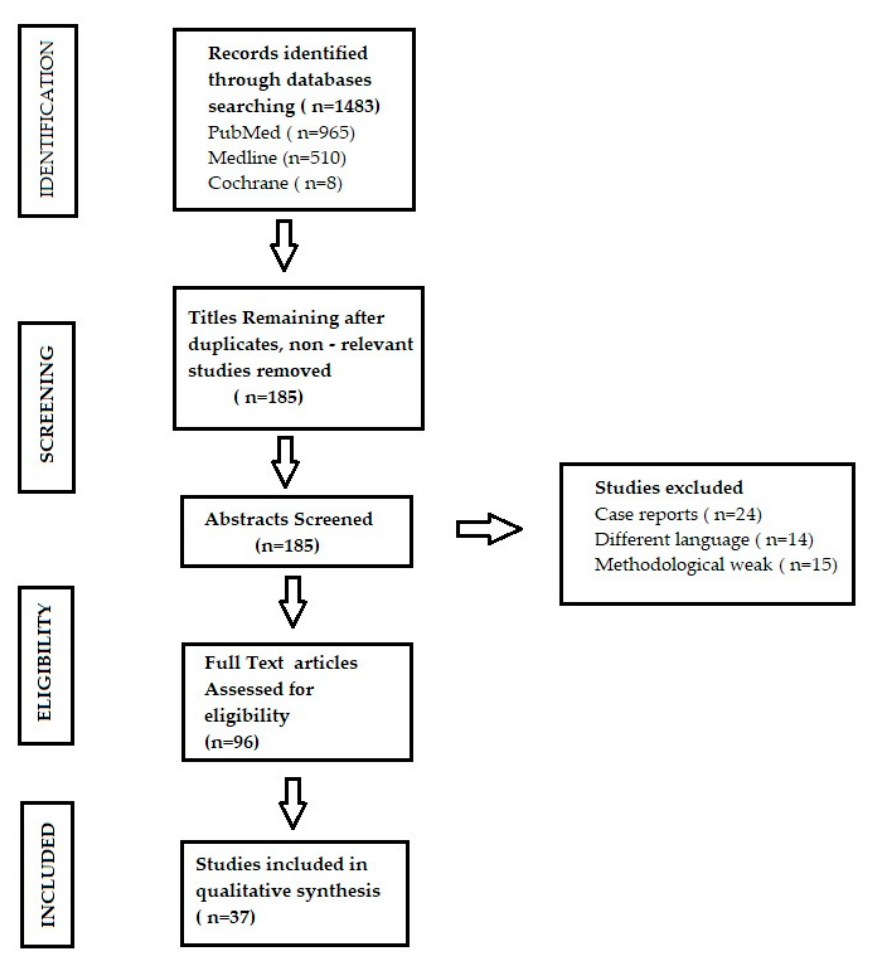
Figure 1. Flowchart for the review.